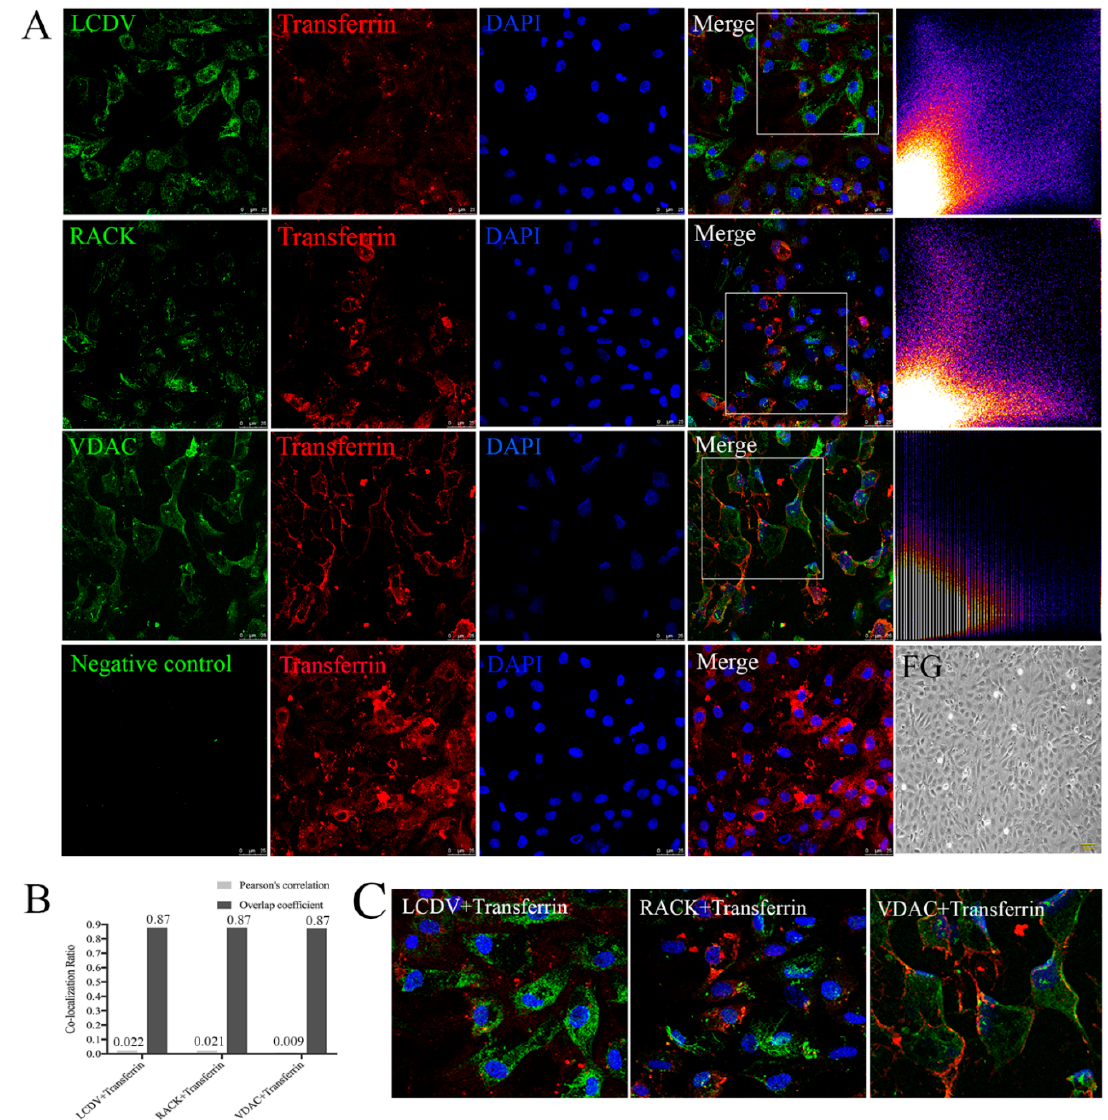
Figure 10. LCDV, VDAC2, and RACK1 do not co-localize with transferrin on FG cells. ( A ) The co-localization of LCDV, VDAC2, and RACK1 with transferrin analyzed by confocal microscopy; scatter plots represent the co-localization analysis of the merged images using ImageJ software, distinct bifurcations of the scattered blots indicated no co-localization existing, bars = 25 µ m. Uninfected FG cells were shown as a control, bars = 100 µ m. ( B ) Pearson’s correlation and overlap coe ffi cients of the merged images analyzed by ImageJ software. ( C ) Higher magnification on framed areas of merged figures in ( A ). Rabbit pre-immune serum instead of primary antibody served as a negative control. LCDV and transferrin were inoculated to FG cells at 22 ◦ C for 2